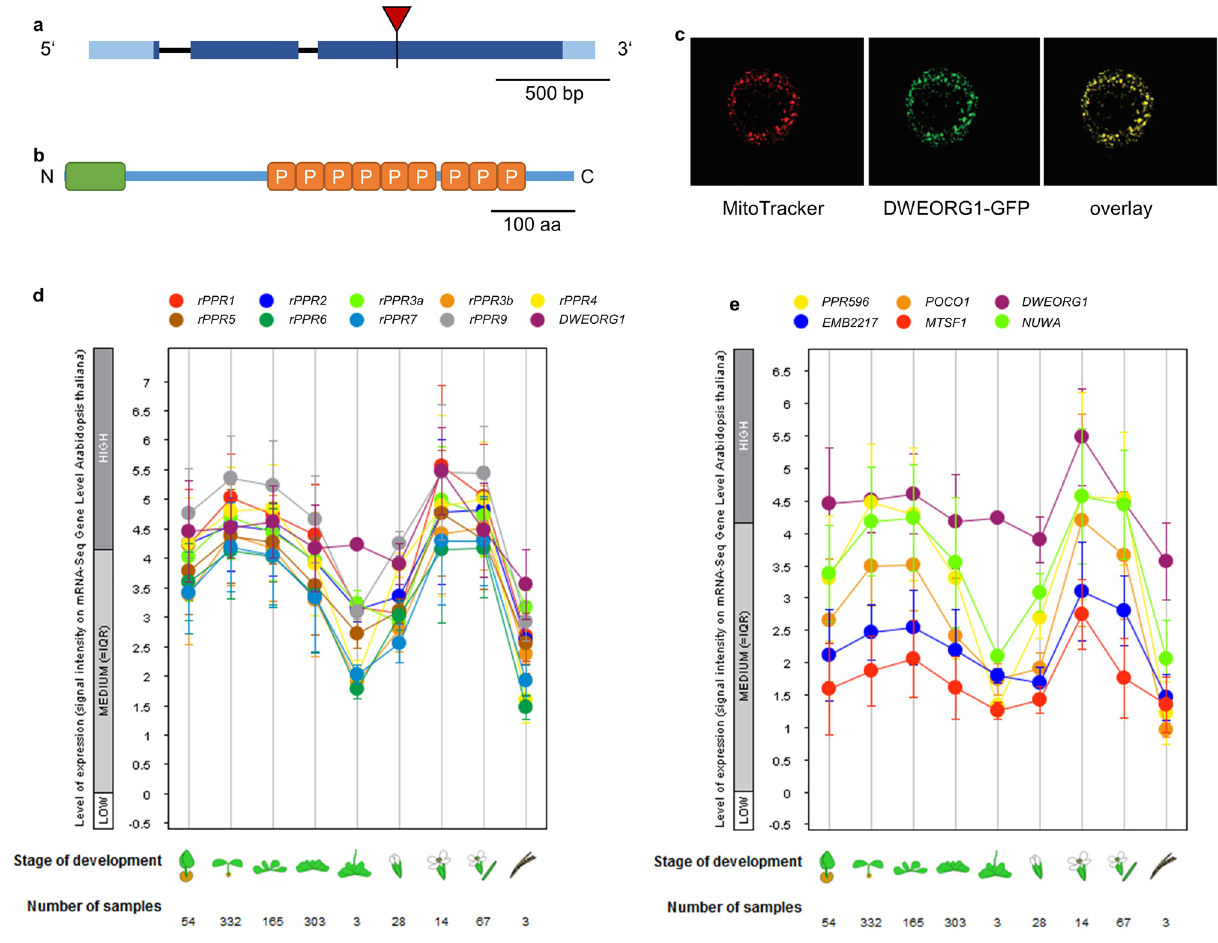
Figure 1. dweorg1 encodes a mitochondria-targeted PPR protein, and its expression profile is highly similar to that of ribosomal PPR genes. ( a ) dweorg1 gene structure and position of the T-DNA insertion site in the third exon (red triangle). Exons and introns are shown as dark blue boxes and black lines, respectively. UTRs are depicted in light blue. ( b ) DWEORG1 protein structure. The mitochondrial signal peptide, predicted by TargetP, is shown as a green box. The P-type PPR motifs are shown as orange boxes (P). ( c ) Confocal laser scanning microscopy images of an Arabidopsis thaliana leaf protoplast transiently expressing a DWEORG1–eGFP fusion protein (green signal) and also stained with the MitoTracker mitochondrial marker (red signal). The GFP signal and MitoTracker signals overlap perfectly (yellow). ( d ) Expression patterns of rPPR1 , rPPR2 , rPPR3a , rPPR3b , rPPR4 , rPPR5 , rPPR6 , rPPR7 , and rPPR9 genes throughout Arabidopsis development in comparison with that of DWEORG1 . The figure was made with GENEVESTIGATOR 40 . ( e ) Expression pattern of mitochondrially located P-type PPR protein genes PPR596 , POCO1 , EMB2217 , MTSF1 , and NUWA throughout Arabidopsis development in comparison with that of DWEORG1 . The figure was made with GENEVESTIGATOR 40